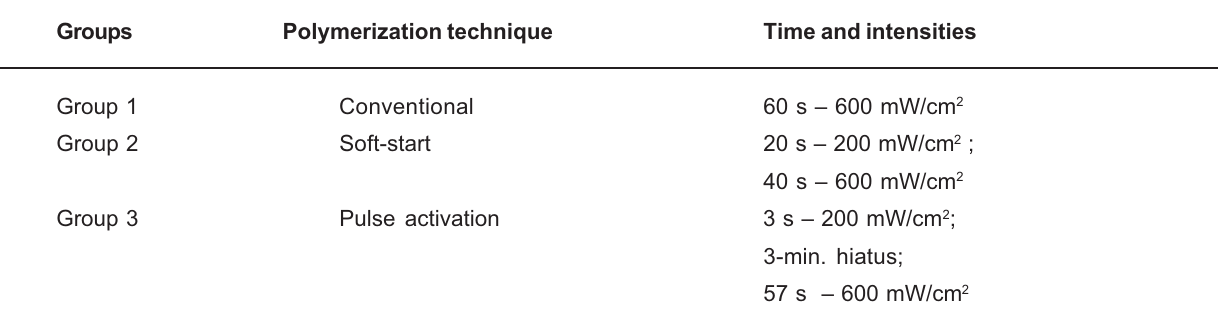
TABLE 2- Studied groups according to the variables considered